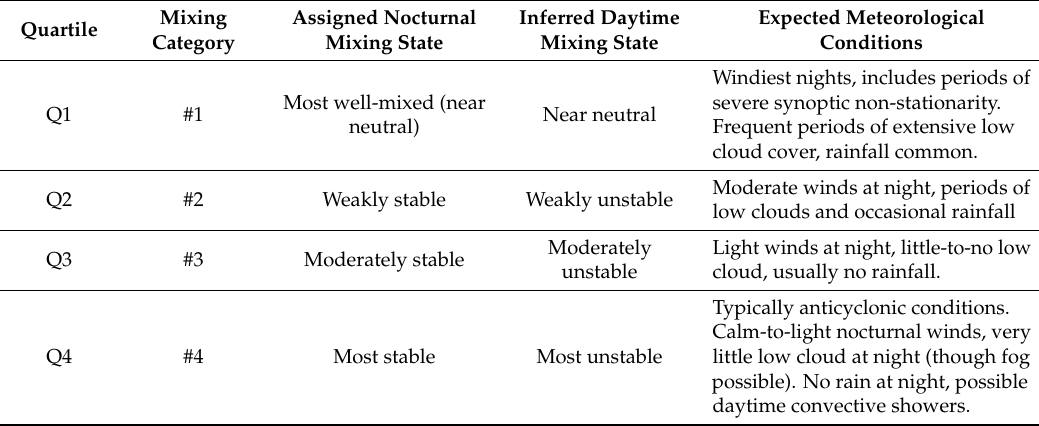
Table 1. Radon-based definition of 24-h relative atmospheric mixing